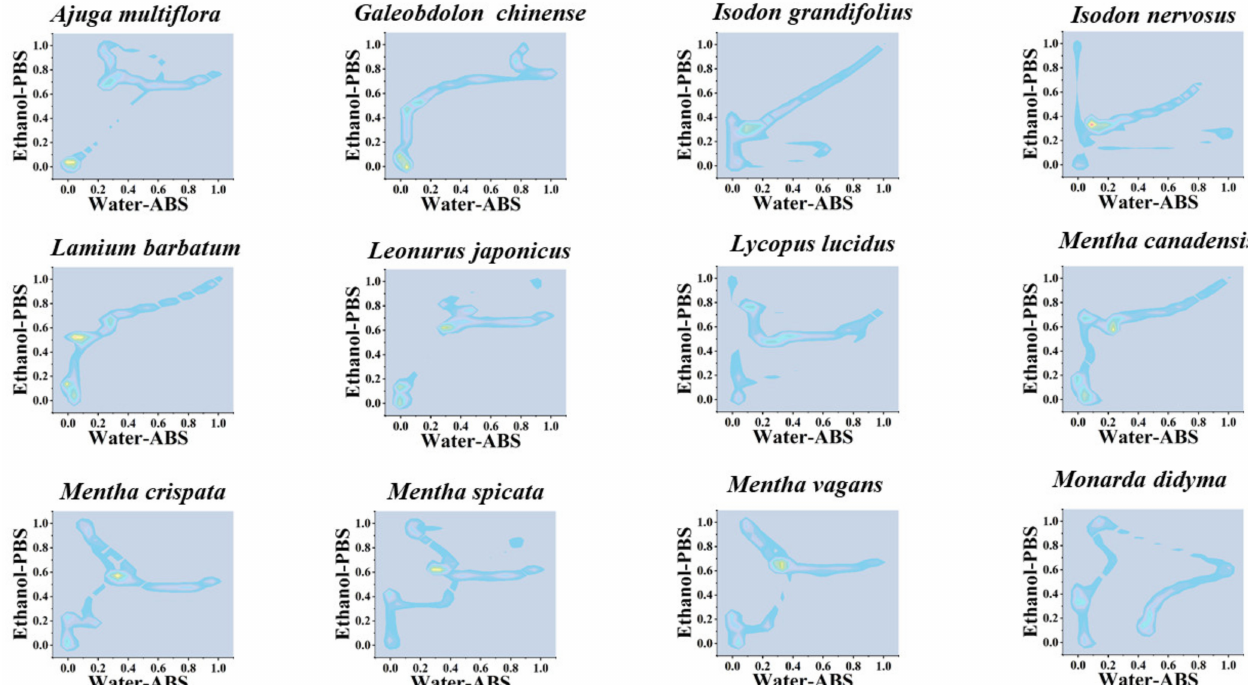
Figure 4. Two-dimensional density map of 12 species of Lamiaceae combining the signals collected under PBS for the water extracts and under ABS for the ethanol extracts (The remaining 24 species can be found in Supplementary